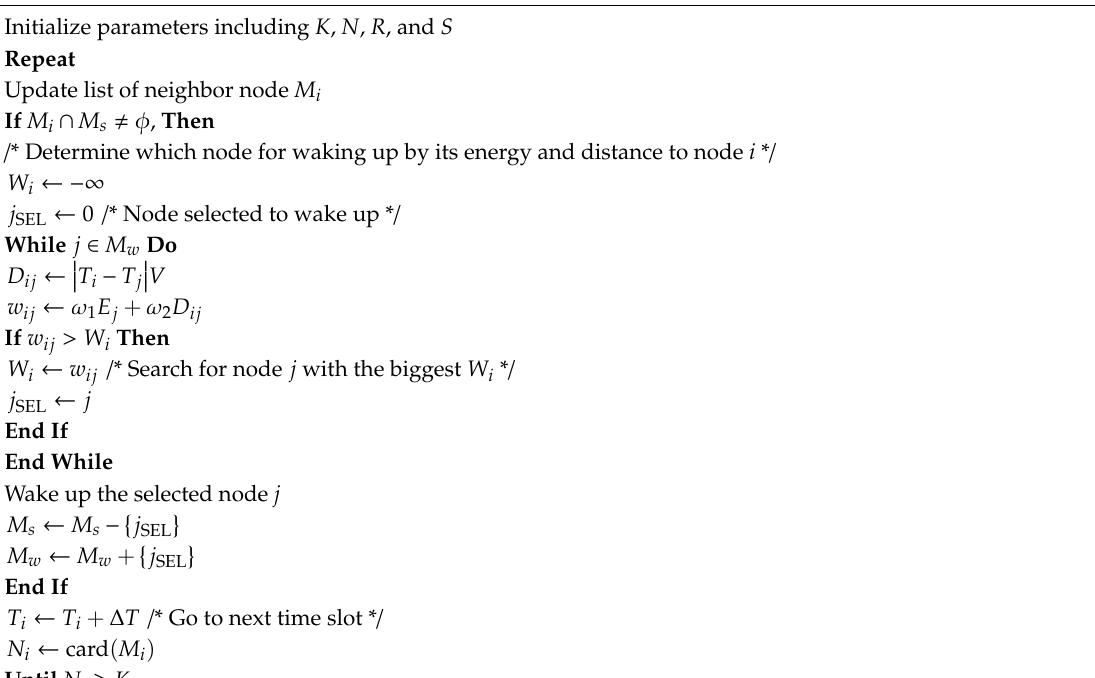
Algorithm 1. Connectivity and Energy E ffi ciency (CEE)